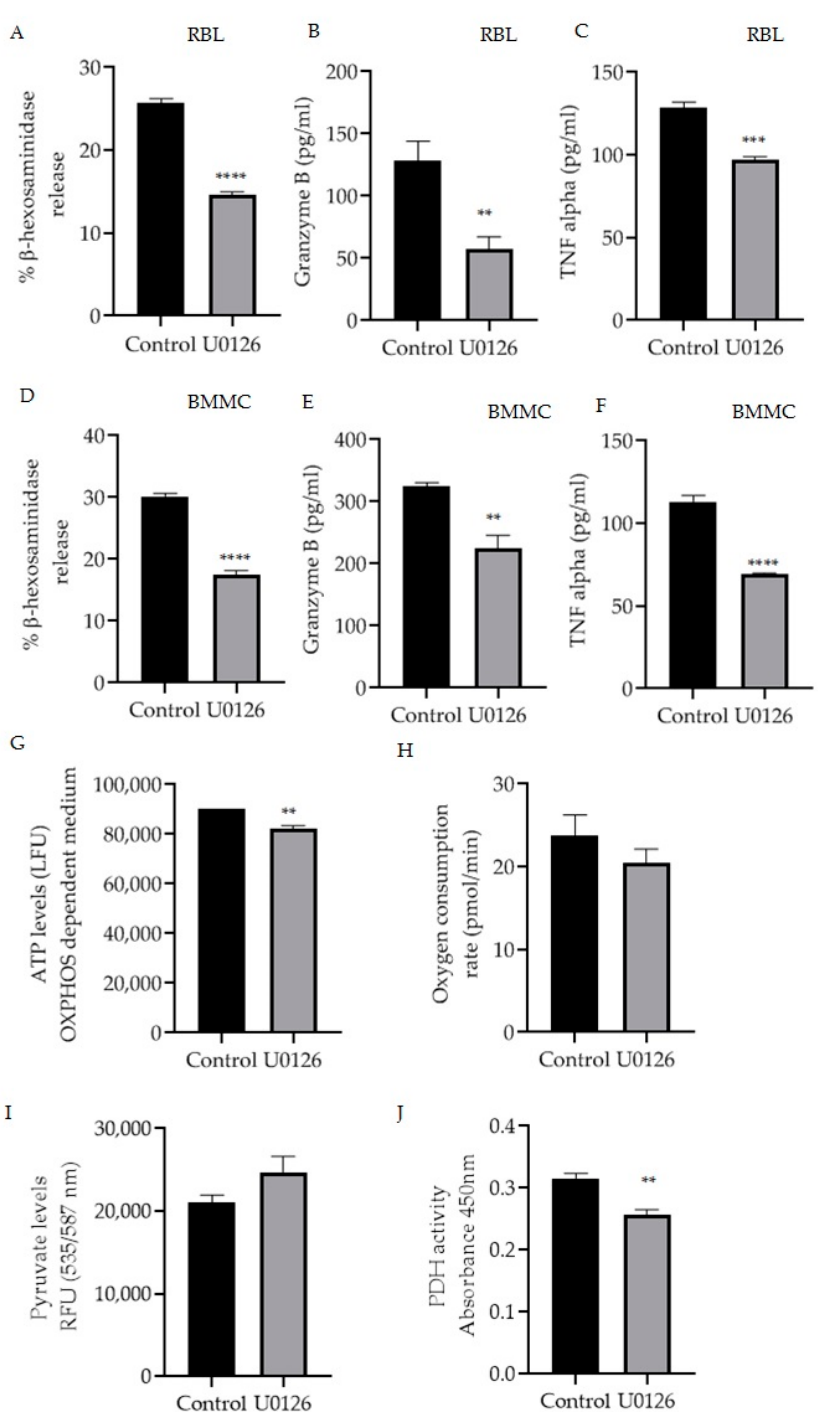
Figure 4. Inhibition of mitochondrial MITF Serine 73 phosphorylation using U0126 affects mast cell degranulation and mitochondrial functions. Mast cells were stimulated with IgE-DNP and incubated either with 20 µ mol/L U0126 or DMSO as control and degranulation activity was assessed by measuring β -hexosaminidase release and cytokine (TNF- α , granzyme B) secretion using the ELISA assays in RBL cells ( A – C ) and BMMCs ( D – F ). Mitochondrial activity assay results are shown in ( G ) mitochondrial ATP, ( H ) Oxygen consumption rate with the increased pyruvate levels ( I ) and the decreased pyruvate dehydrogenase activity ( J ) in RBL cells. A two-tailed Student’s t -test was performed for all the assays. Results represent means ± SEMs (n = 4, **** p ≤ 0.0001; *** p ≤ 0.001; ** p ≤ 0.01; ns p >